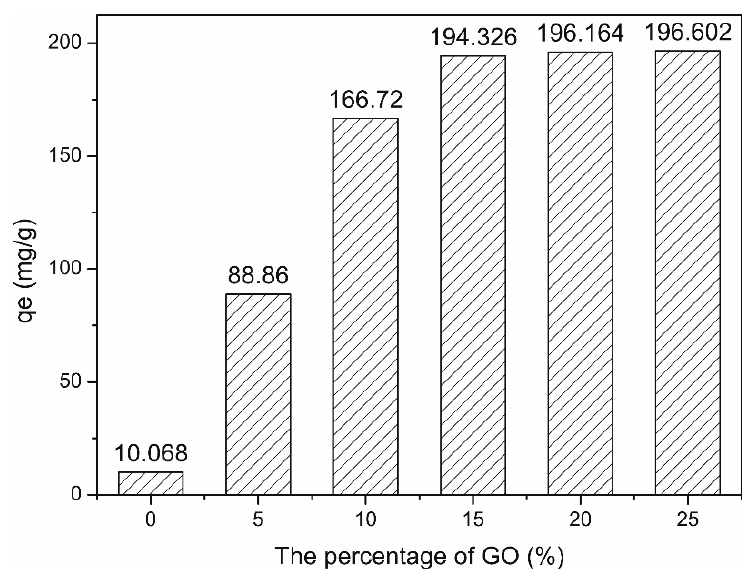
Figure 7. Percentage of GO, MB solution: 20 mL, 100 mg/L, Room temperature (20 °C).